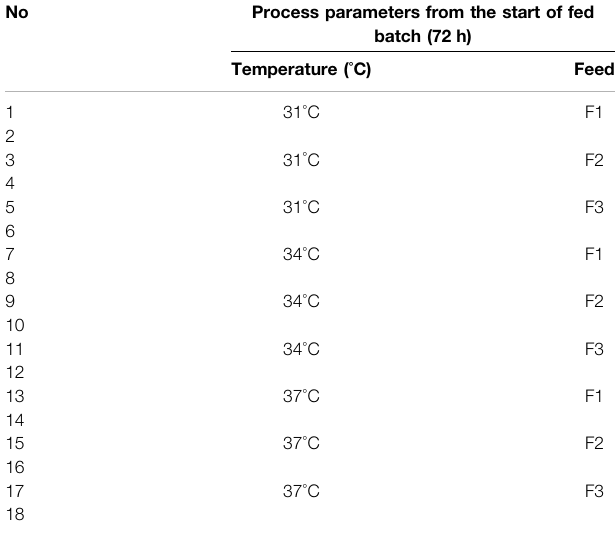
TABLE 1| Used process parametersand runnumbers for the 18shake fl ask DoE experiments. F1, F2, and F3 represent the amount of added glucose in the feed: 10, 20, and 30 g L − 1 ,